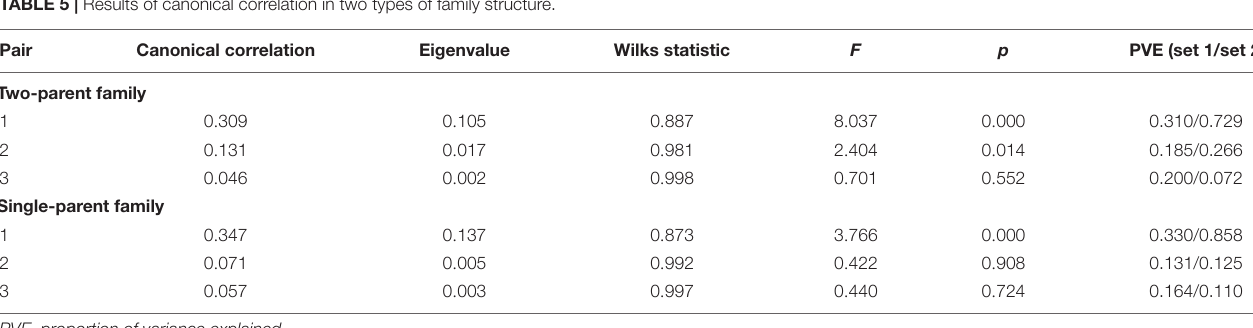
TABLE 5 | Results of canonical correlation in two types of family structure.